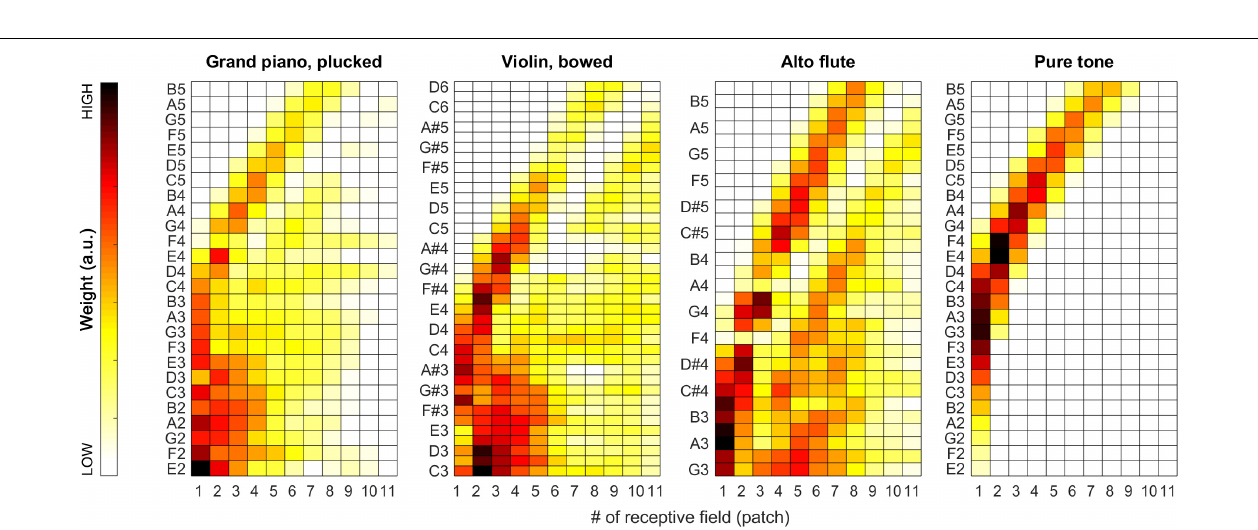
FIGURE 11 | Median of the weights (over all 100 iterations) for the complete tested pitch range for the grand piano (leftmost plot), the violin (second plot), and the alto flute recordings (third plot), and for pure tones (rightmost plot).